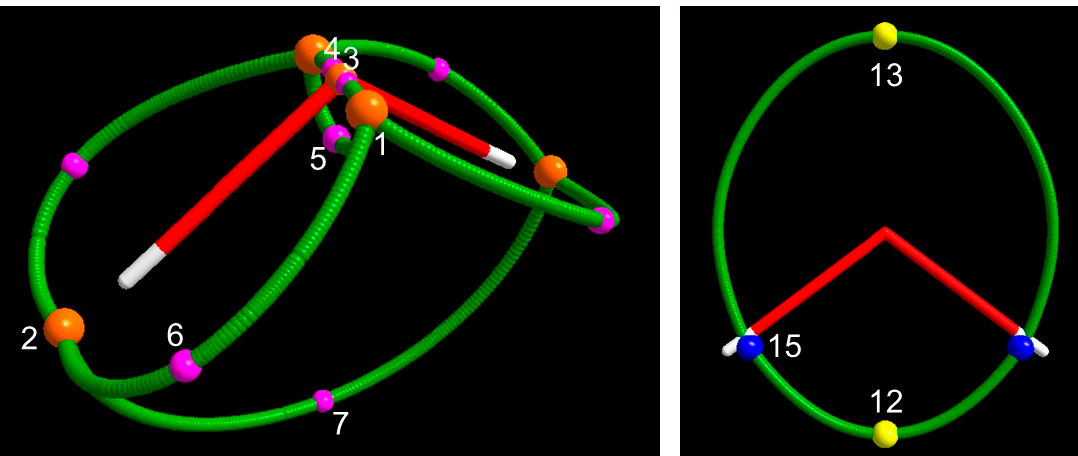
Figure 3. CAS spin density maxima joining paths: α – α , positive spin density regions (s + , left); β – β , negative spin density regions (s − , right). In both panels, the ∇ ρ bond paths are also shown (from H nucleus to the bond critical point (bcp) in white and from bcp to O nucleus in red). Critical points of s( r ) are labelled as in Tables 2 and 3 and portrayed as colored balls ((3, − 3) s maxima, orange; (3, − 1) s saddles, violet; (3, +3) s minima or –s maxima, blue; (3, +1) s ring or –s (3, − 1) saddles, yellow). The α – α and β – β spin maxima joining paths are represented as thick green wires. The β – β spin density maxima joining paths all lie in the σ v plane of 3 B 1 H 2 O, i.e., that defined by CPs 2, 2’ and 3 in the left panel. The pictures were obtained through the code Diamond v3.21 [39].